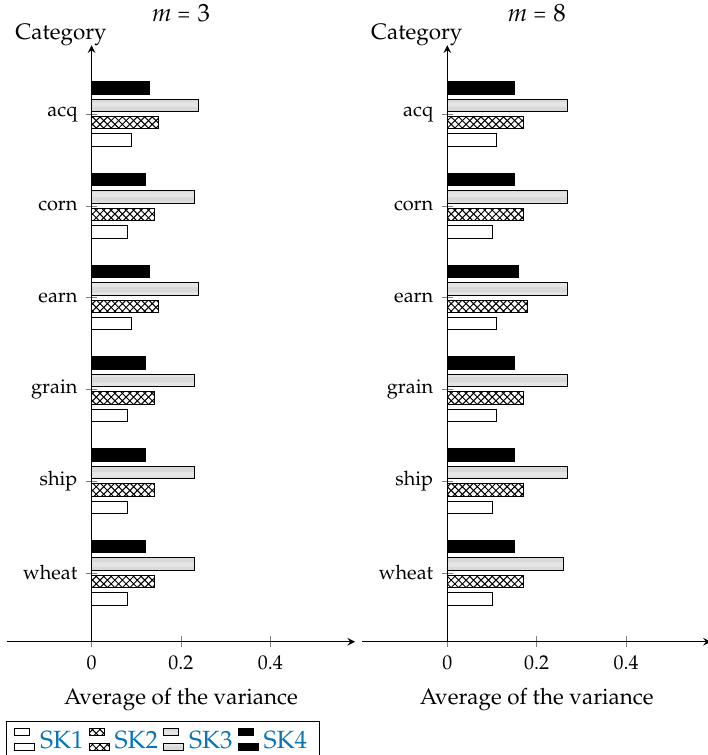
Figure 4. Average of the variance of the computed collective concordance indices per category ( m = 3 and m = 8).